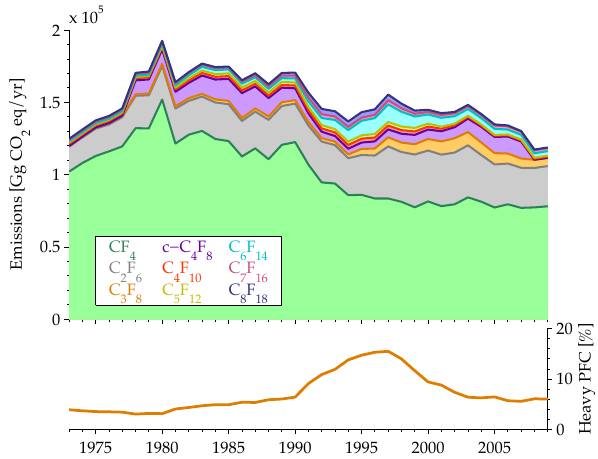
Fig. 6. Global annual PFC emissions in CO 2 equivalents, using GWPs with a 100-yr time horizon, from 1973 to 2009. The CF 4 , C 2 F 6 and C 3 F 8 emissions are from M¨uhle et al. (2010) and the c − C 4 F 8 emissions are from Oram et al. (2012). The bottom panel shows the relative percentage the high molecular weight PFCs stud- ied here contribute to the new global total of PFC emissions in CO 2